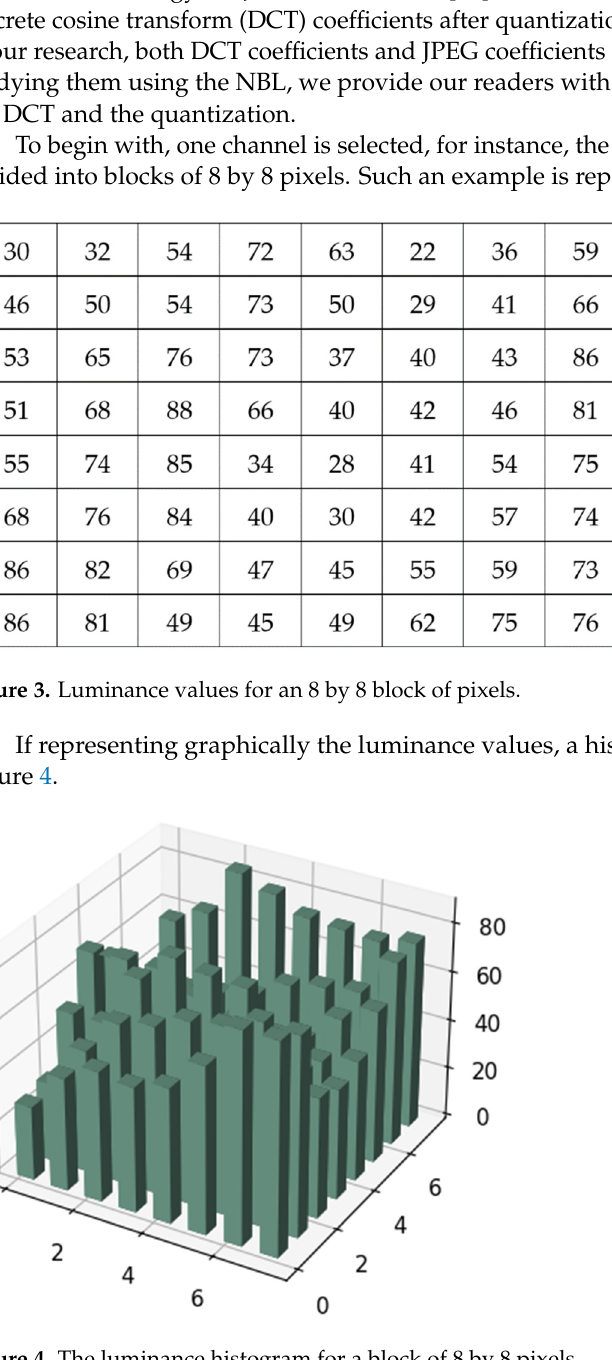
Figure 5. Pixels values in range [ − 128, 127]. Then, for each block, the two-dimensional discrete cosine transform is applied. This transformation is a sum of cosines, a sum in which the terms’ coefficients are in decreasing order. Moreover, it is performed in a zigzag manner, as shown in Figure 6. Figure 6. The zigzag rule of the discrete cosine transform. Therefore, the top left value in our 8 by 8 block, which is the first coefficient of the DCT, has the biggest value [28]. Then, the DCT coefficients decrease. Consequently, the